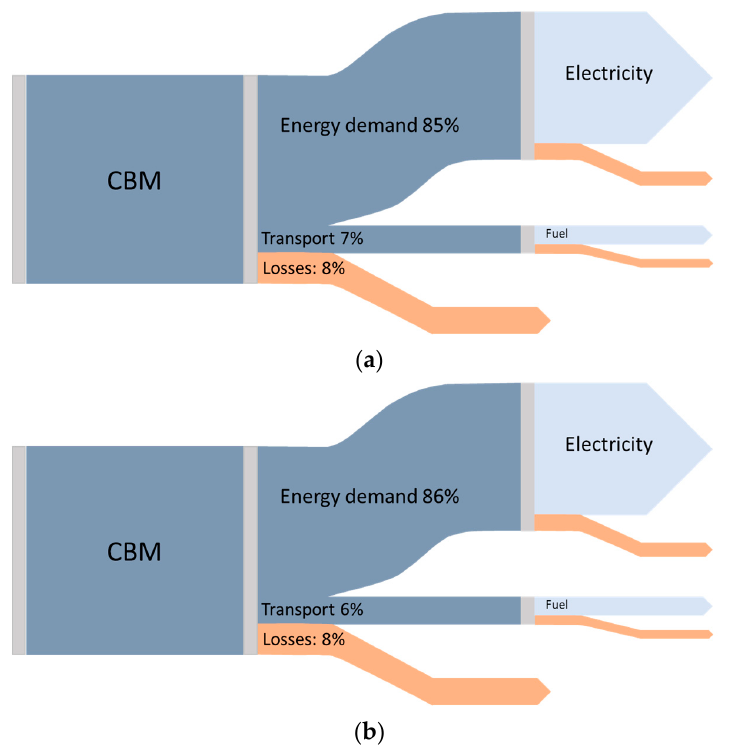
Figure 6. Exegetic diagram of the use of CBM for transport and energy. ( a ) Russia, ( b ) Europe.